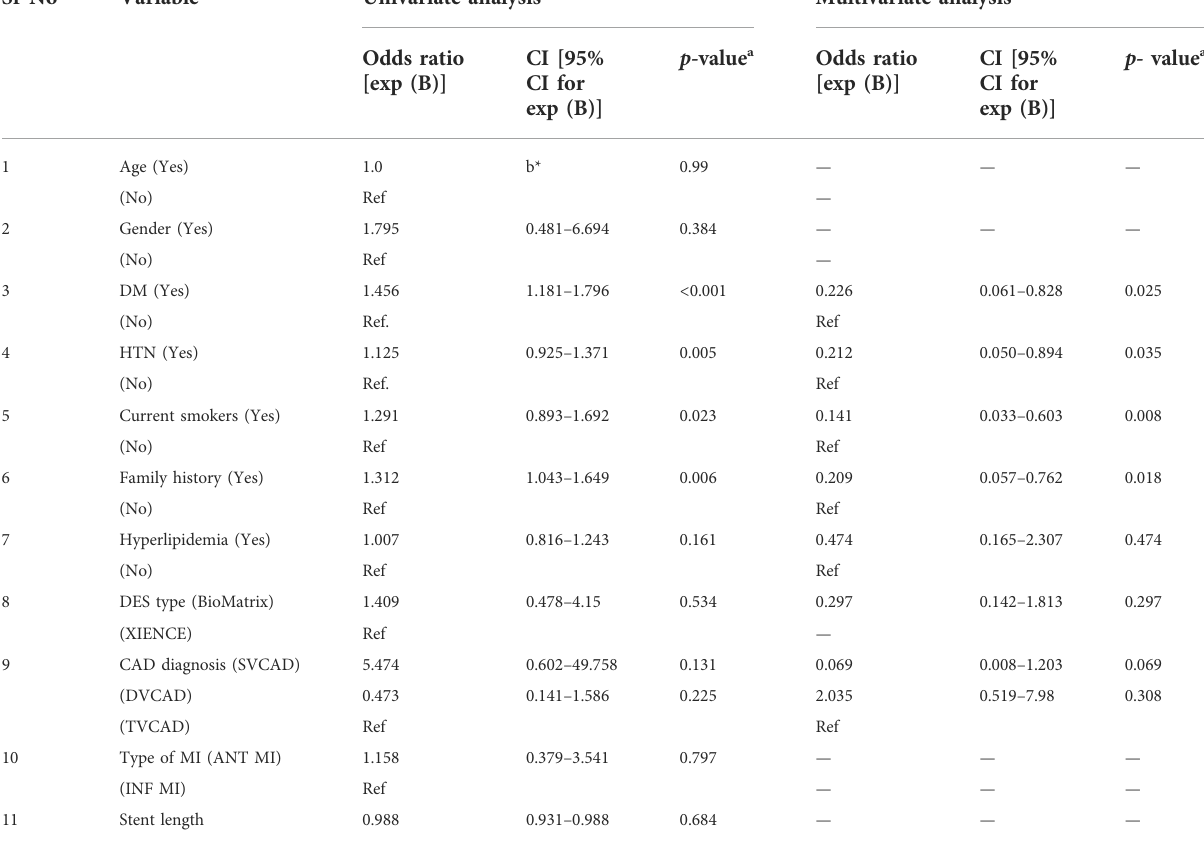
TABLE 5 Factors associated with the occurrence of MACEs. of MACEs was more in XIENCE stents (4.75%) than in BioMatrix (3.44%) stents.